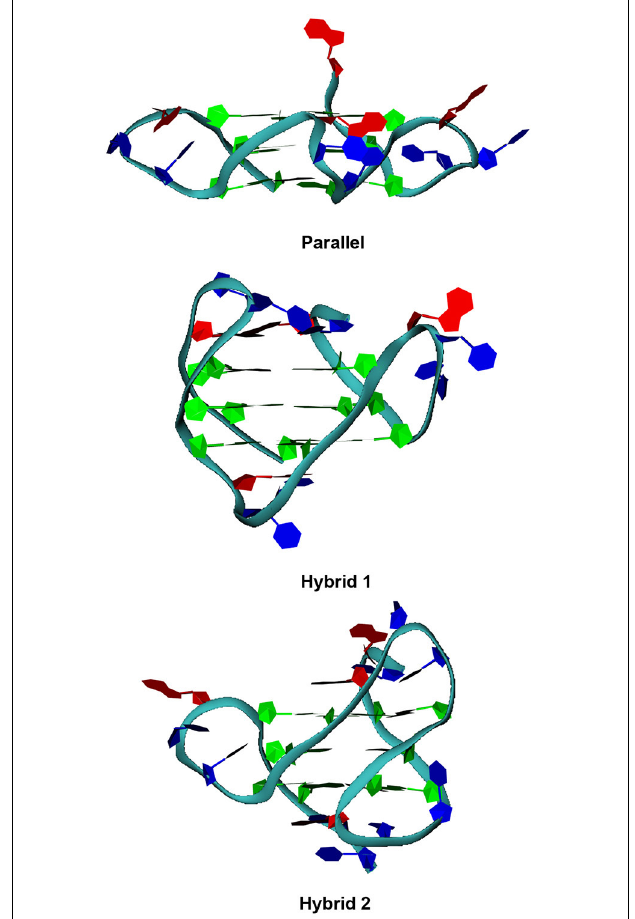
FIGURE 2 | G-quadruplex folding topologies. Pictorial representations of the parallel, hybrid 1 and 2 folding topologies of human telomeric